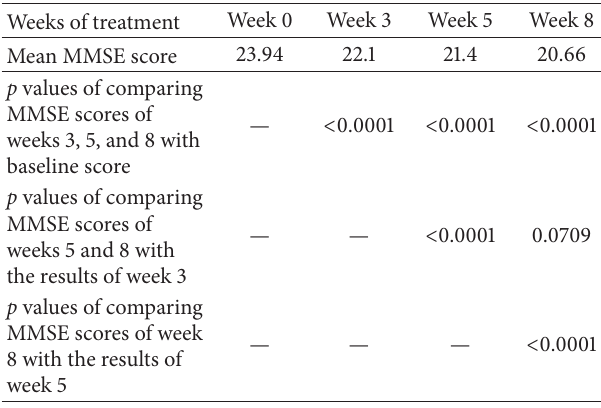
Table1:Resultsofpatients’cognitiveassessmentpriortoandduring treatment with SSRs (number of patients =